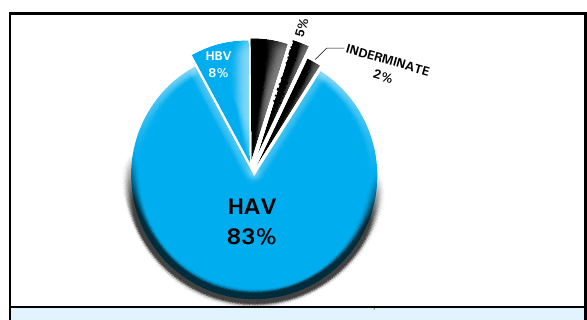
Figure 1. Etiology of acute viral hepatitis